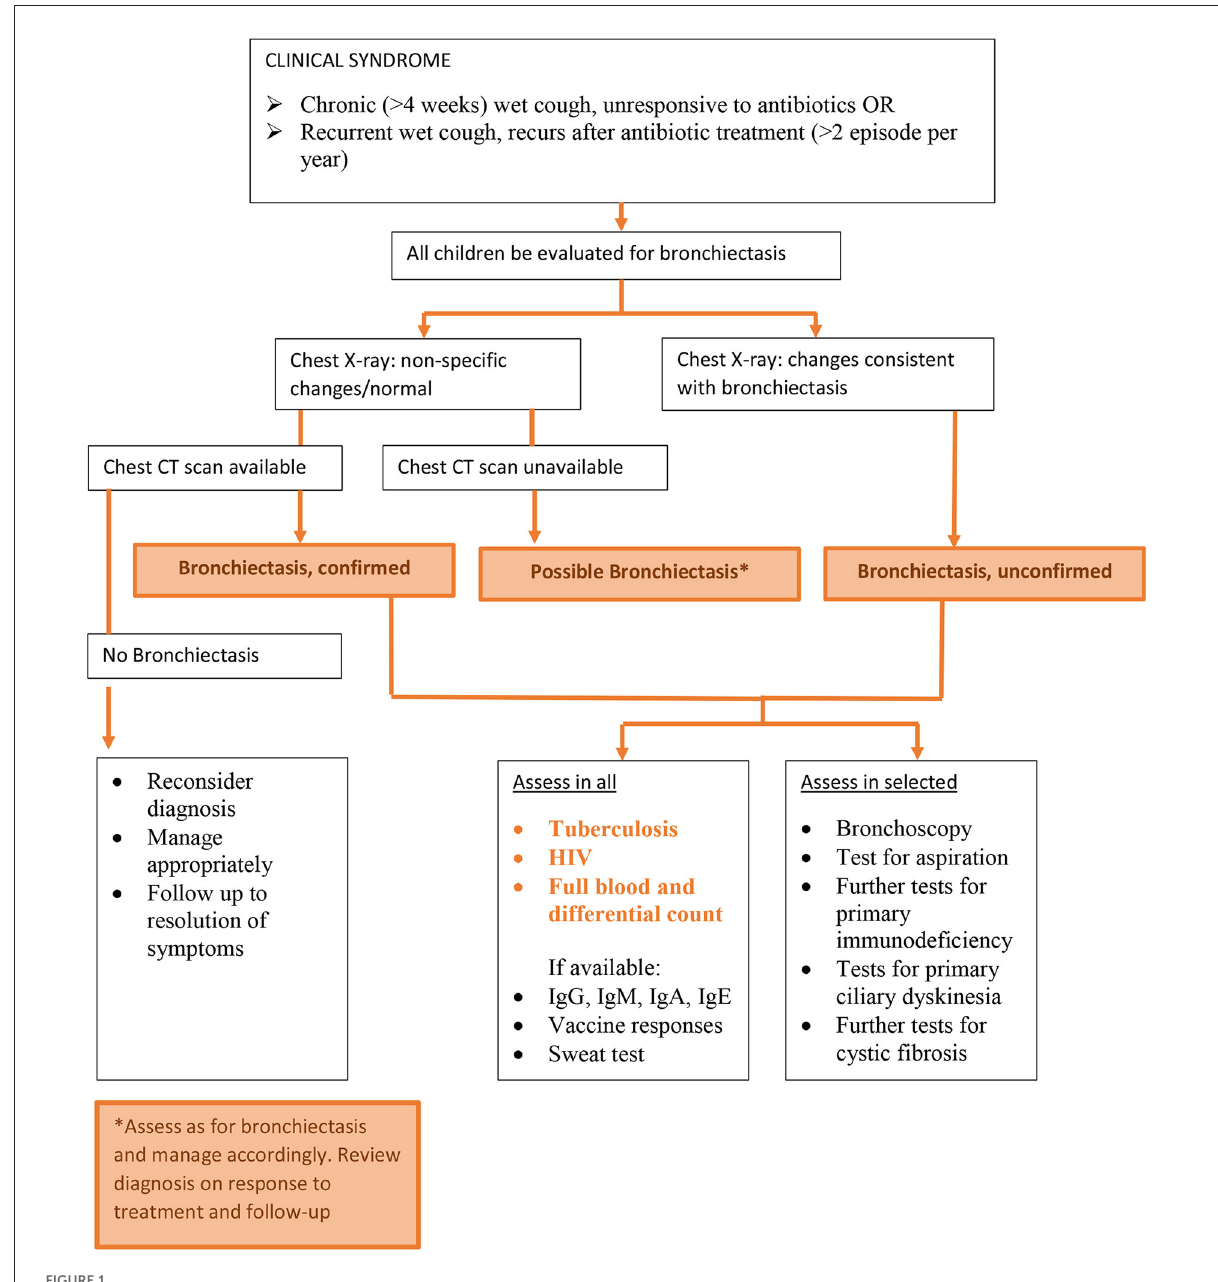
FIGURE1 Diagnosing and investigating childhood bronchiectasis in